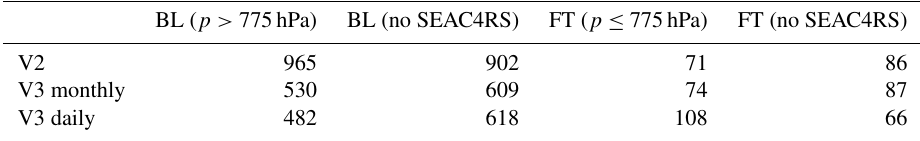
Table 2. Mean absolute bias between each of the types of simulated NO 2 profiles and the aircraft profiles shown in Fig. 1. Values are given for the boundary layer (BL) and free troposphere (FT), with the divide at 775hPa ( ∼ 2km). All values are in parts per trillion by volume